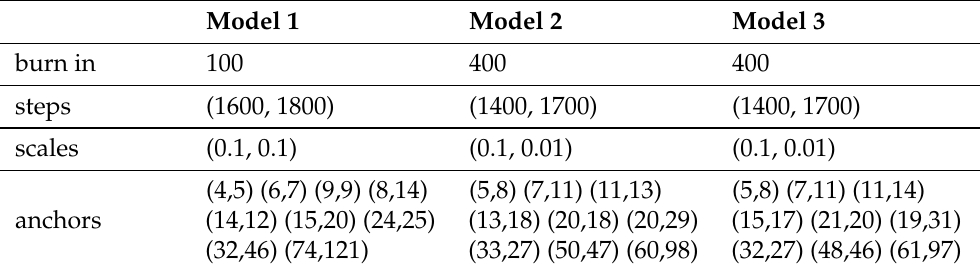
Table 1. Training parameters for Model 1, 2 and